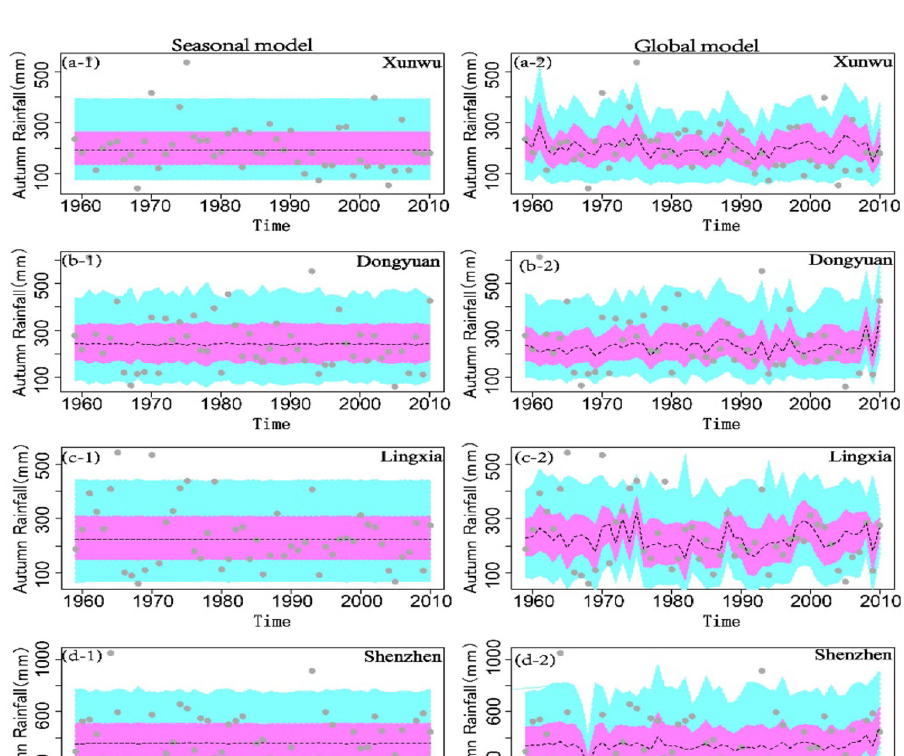
Fig. 8 Modeled summer precipitation by the seasonal model (left) and the global model (right) at four selected stations (Xunwu, Dongyuan, Lingxia, and Shenzhen) in the East River basin in southeastern China. The black dashed line denotes the 50% percentile, the pink region stands for the interval defined by the 25 and 75% percentiles, and the greenish-blue region displays the interval defined by the 5 and 95% percentiles. The grey points denote the observed precipitation data